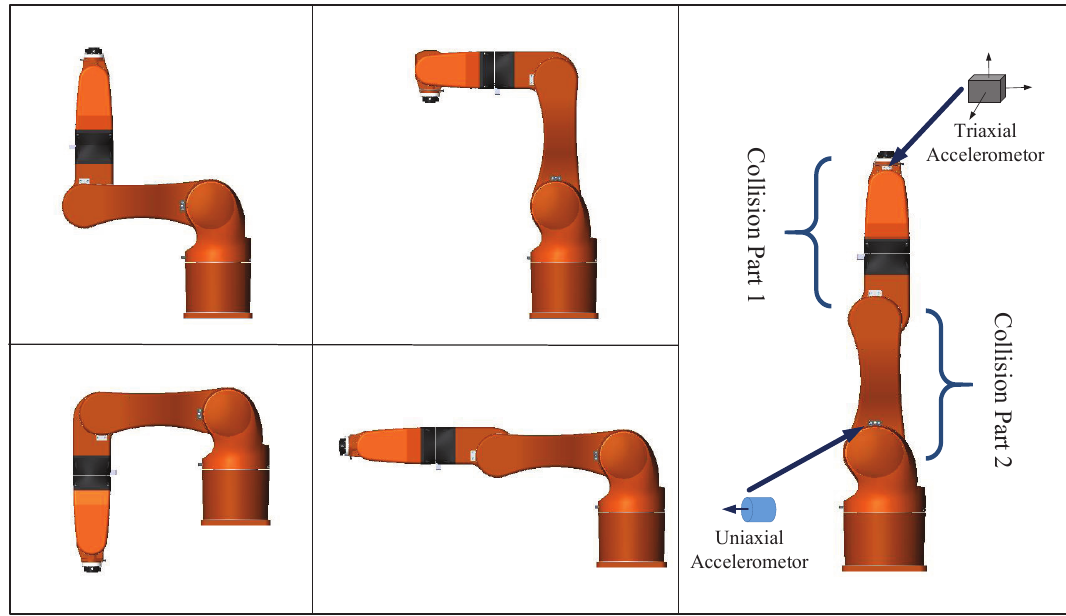
Figure 10. Five testing patterns of